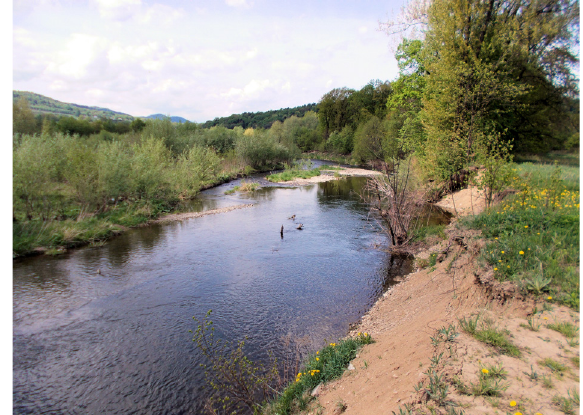
Fig. 7. The section of the Skawa river near Jaroszowice village. Photo: K. Witkowski. Table 1. The criteria of a scientific-educational assessment. Based on Pereira, Pereira (2010) and Brilha (2016).